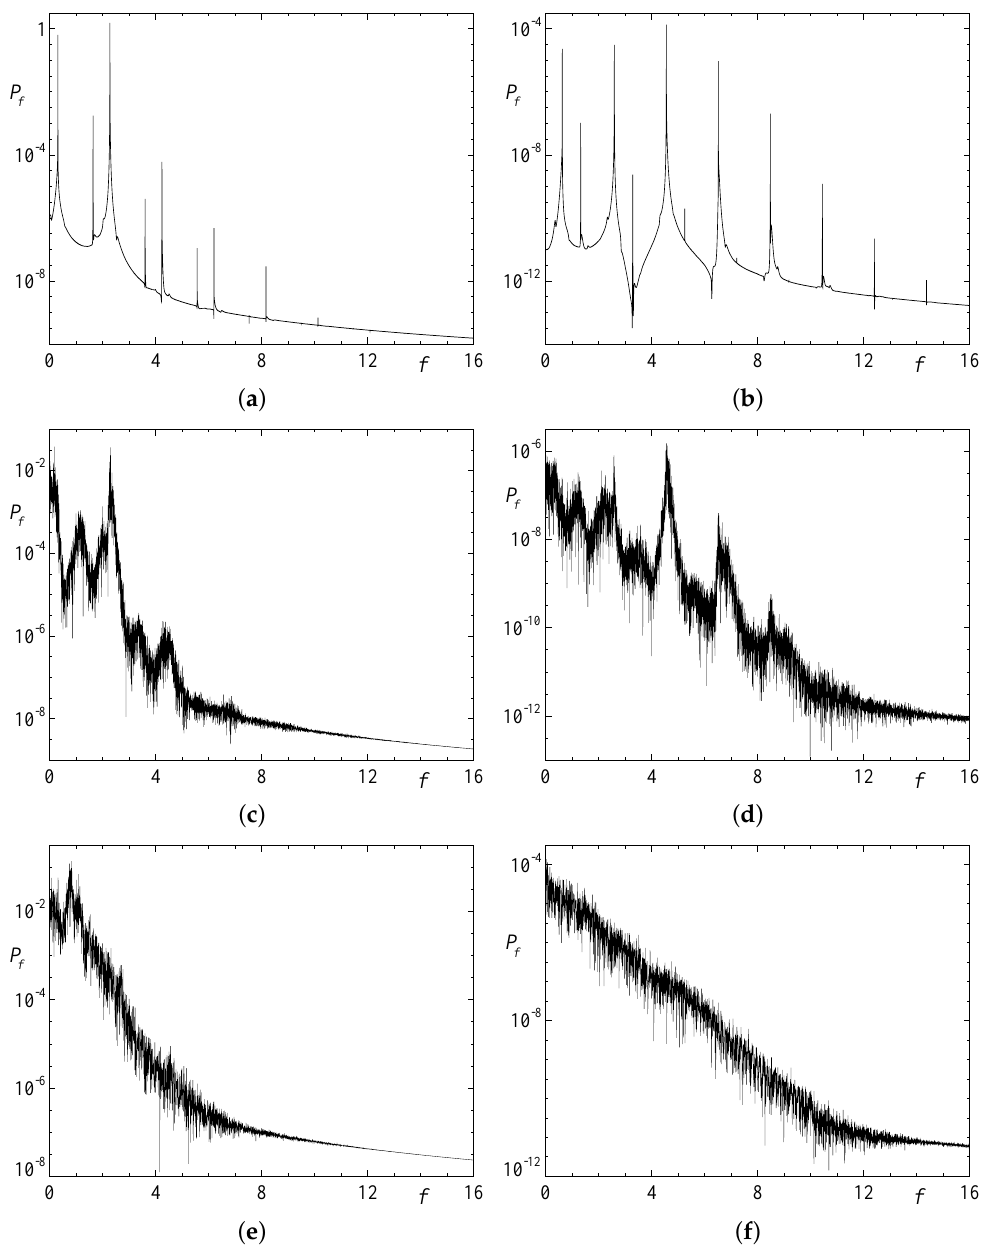
Figure 8. Temporal power spectra of the Fourier coefficients Re ˆ v 1 column) in run 2 x 1.2 in the time intervals 285 ≤ t ≤ 1555 (phase G), (a), (b); 1580 ≤ t ≤ 1940 (phase S), (c), (d); and 2000 ≤ t ≤ 2200 (phase D), (e),